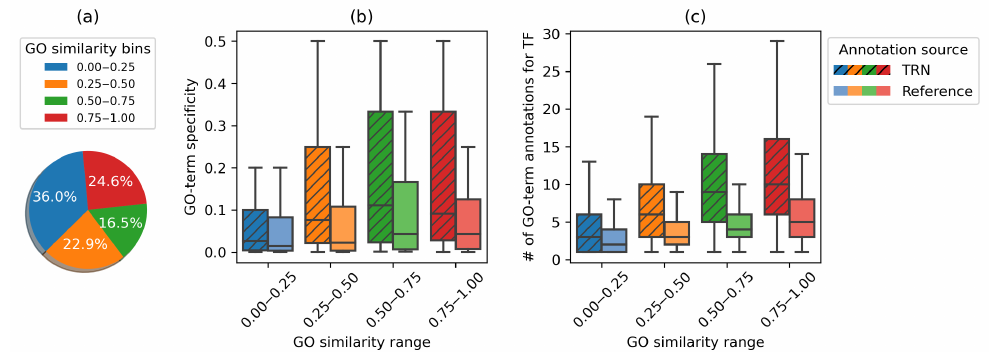
Figure 7. ( a ) Similarity between reference and predicted functional annotations. TFs are binned based on the similarity score between the reference and predicted GO terms. ( b ) Distribution of TF annotation specificity (Equation (6)) for GO terms predicted by TRN or listed in the reference database. TRN-predicted GO terms have higher specificity. ( c ) Distribution of the number of GO terms for individual TFs predicted by TRN and available in the reference database. TRN is able to predict more functional annotations than are listed in the current knowledge